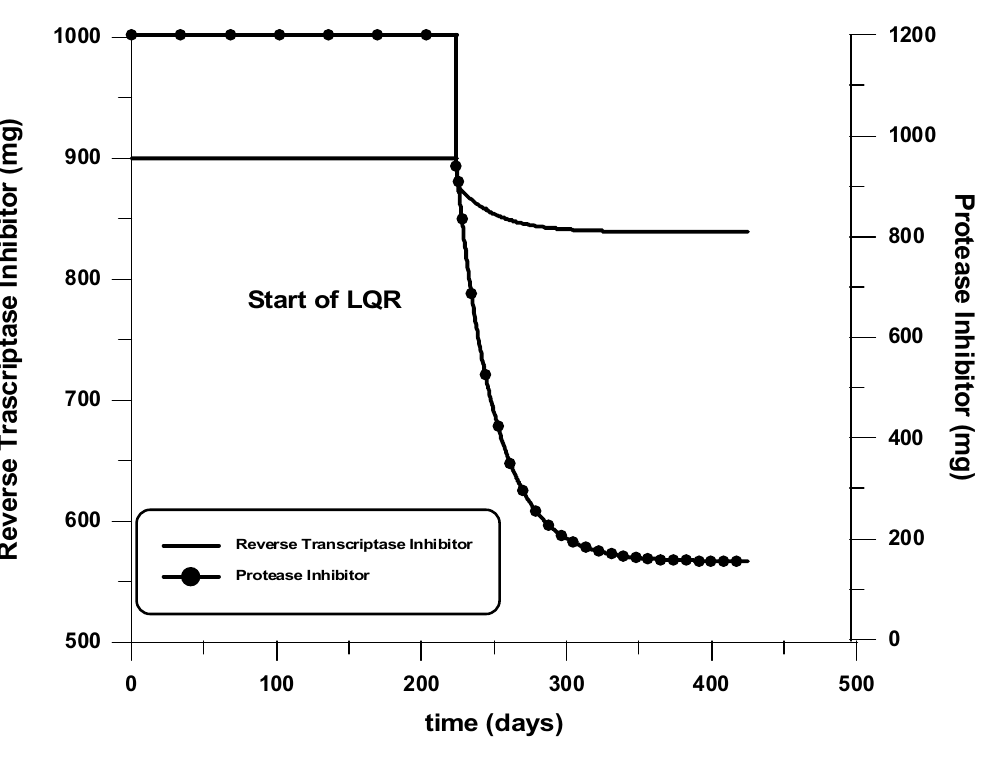
Fig. 4 – Reverse Transcriptase and Protease Inhibitor under